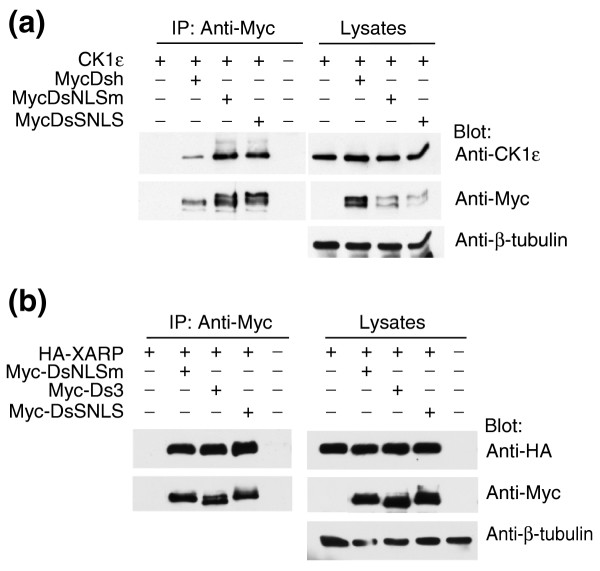
Dsh mutants retain the ability to bind CK1ε and XARP. Four-cell embryos were injected in four sites in the animal hemisphere with CK1ε, HA-XARP, Myc-tagged Dsh, DsNLSm, Ds3 or DsSNLS RNA alone (2 ng each) or in combinations as indicated. The embryonic lysates were collected at stage 10.5 for immunoprecipitation with anti-Myc antibodies. Co-immunoprecipitated (a) CK1ε or (b) HA-XARP was probed with anti-CK1ε or anti-HA antibodies; β-tubulin served as a loading control.